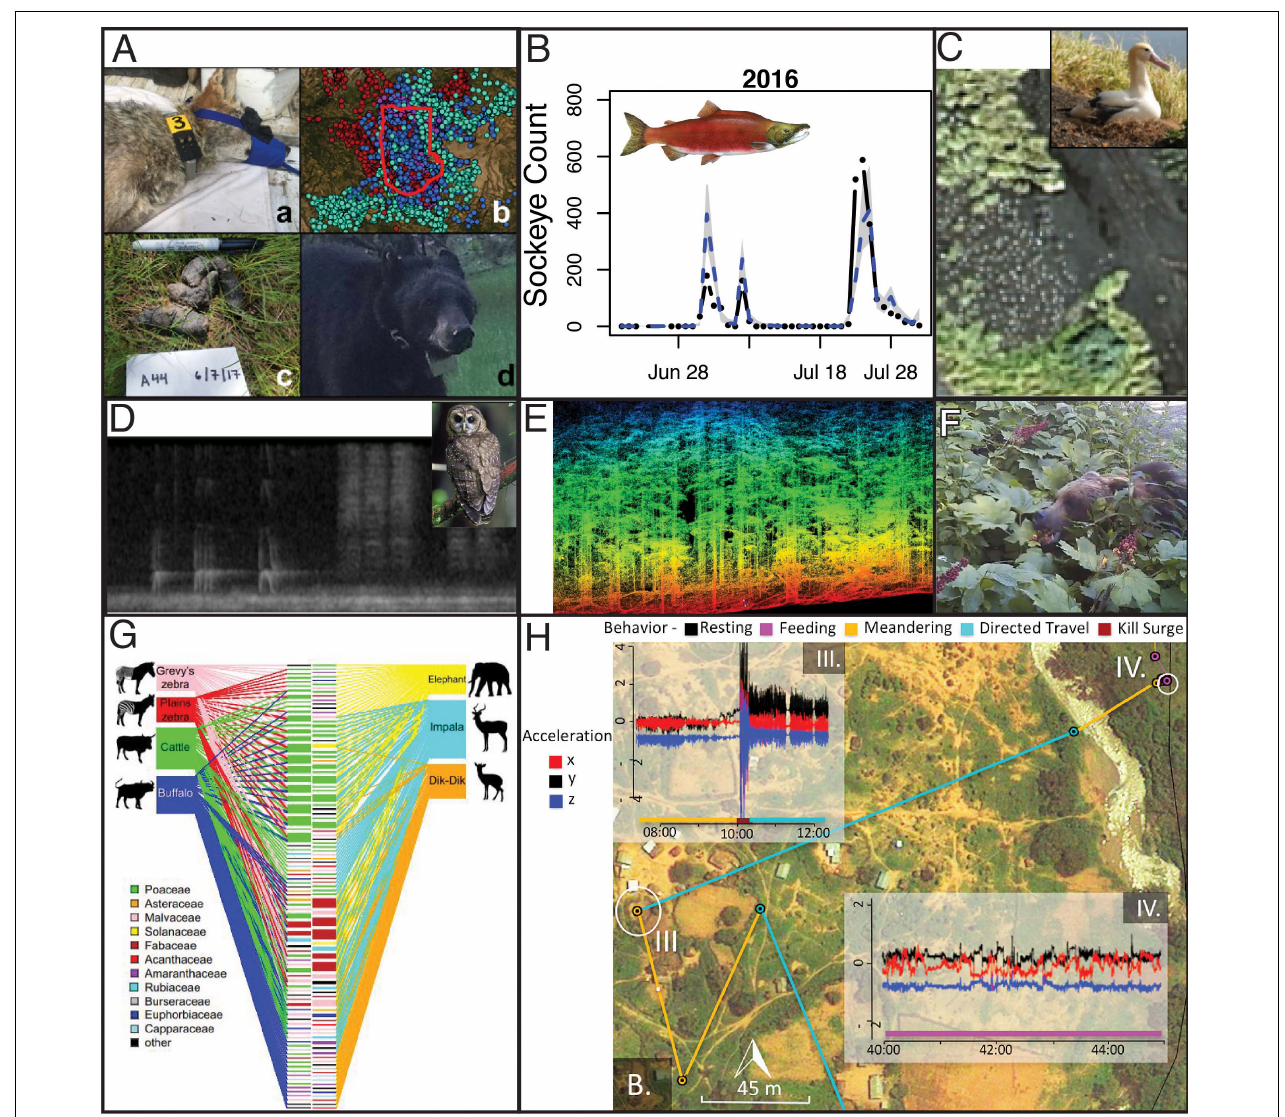
FIGURE 4 | Examples of next-generation natural history research yielding unique insights about descriptions of how nature works. (A) New technologies can be combined. For example, Ruprecht et al. (2020) integrated information from GPS telemetry, camera traps to resight marked individuals, and genotypes from scats to estimate local population densities of four carnivores while testing a suite of methods for animal density estimation. (B) Levi et al. (2019) showed that flow-corrected eDNA rates (blue line) are predictive of actual salmon counts at a weir (black dots), suggesting the environmental DNA can be used to enumerate salmon and track their phenology on larger scales using water samples. (C) Animals can also now be counted from space, including animals as small as albatross, which Dolliver (2019) counted using imagery from WorldView-3. (D) Bioacoustics is now being used to detect Spotted Owls, Barred Owls, and myriad other species (Ruff et al., 2021) as part of Federal monitoring responsibilities under the Northwest Forest Plan. This will provide information about species occurrence, and migratory phenology of songbirds, from Central California to the Canadian border. (E) Metrics of species occurrence can now be linked to detailed measurements of habitat structure from remote sensing including lidar, which can provide a detailed look at tree size, density, composition, and structure. As such detailed characterizations become available on large spatial scales, a growing suite of species distribution models can help researchers predict where species are likely to occur and why they occur there. (F) Camera traps and eDNA have recently been used to describe species interactions such as the identity of seed dispersers for Devil’s club ( Oplopanax horridus ). By monitoring fruit clusters with cameras or swabbing consumed clusters to genetically identify bear species and sex, Harrer and Levi (2018) showed that brown bears were the dominant dispersers, but that black bears became important once salmon were available, that female bears dispersed more seeds than male bears, and that birds dispersed far fewer seeds than did bears. (G) Diet analysis was once the type of descriptive research that had become discouraged in the academy, but DNA metabarcoding has increased the throughput and taxonomy breadth such that Kartzinel et al. (2015) were able to publish diet analysis for seven African herbivores in Proceeding of the National Academy of Sciences. Their fundamental insight was that herbivores were partitioning the savanna vegetation structure, which facilitates coexistence. (H) Recent advances in biologging and analytical methods now allow researchers to determine not only where animals go, but what behaviors they are exhibiting, and how much energy they are expending by combining GPS with accelerometers. Here Wilmers et al. (2017) were able to characterize the locations of an adult male leopard that killed a domestic goat and then carried it across a river to feed. The leopard exhibited meandering behavior followed by a kill surge (10:00 on accelerometer trace III) followed by directed travel (IV), meandering across the river, followed by feeding.